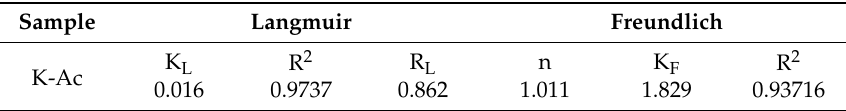
Figure 9. ( A ) Effect of initial concentration for Cd 2+ adsorption by K-Ac; ( B ) Langmuir; ( C ) Freundlich. Table 3. Adsorption isotherm model parameters.